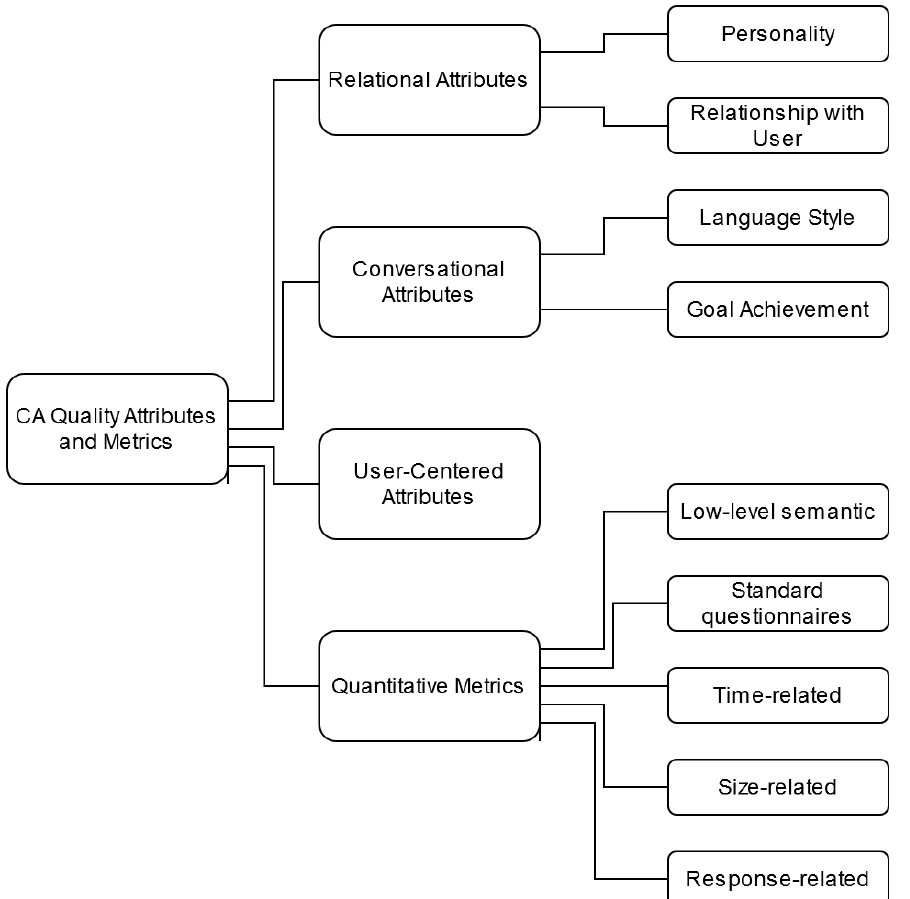
Figure 10. Taxonomy of categories of quality attributes inferred from the final pool of